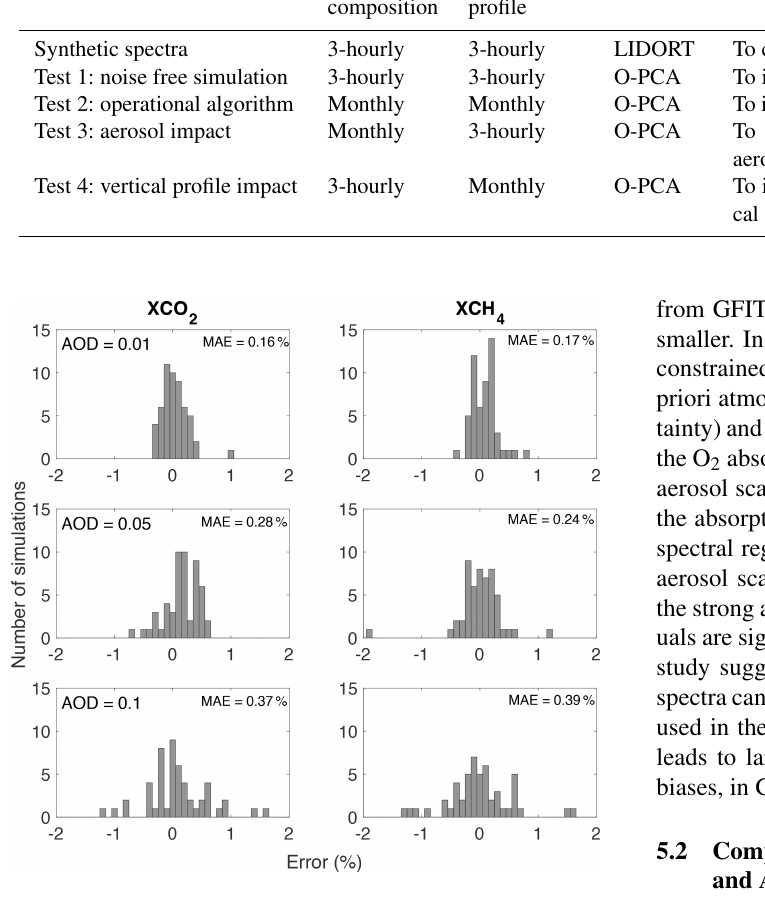
Figure 10. Results for Test 1. Errors in retrieved XCO 2 and XCH 4 are quantified for simulations with three different values of AOD (0.01, 0.05, and 0.1). The errors arise mainly due to the bias caused by the O-PCA approximation compared to the exact atmospheric radiative transfer process. MAE represents the mean absolute